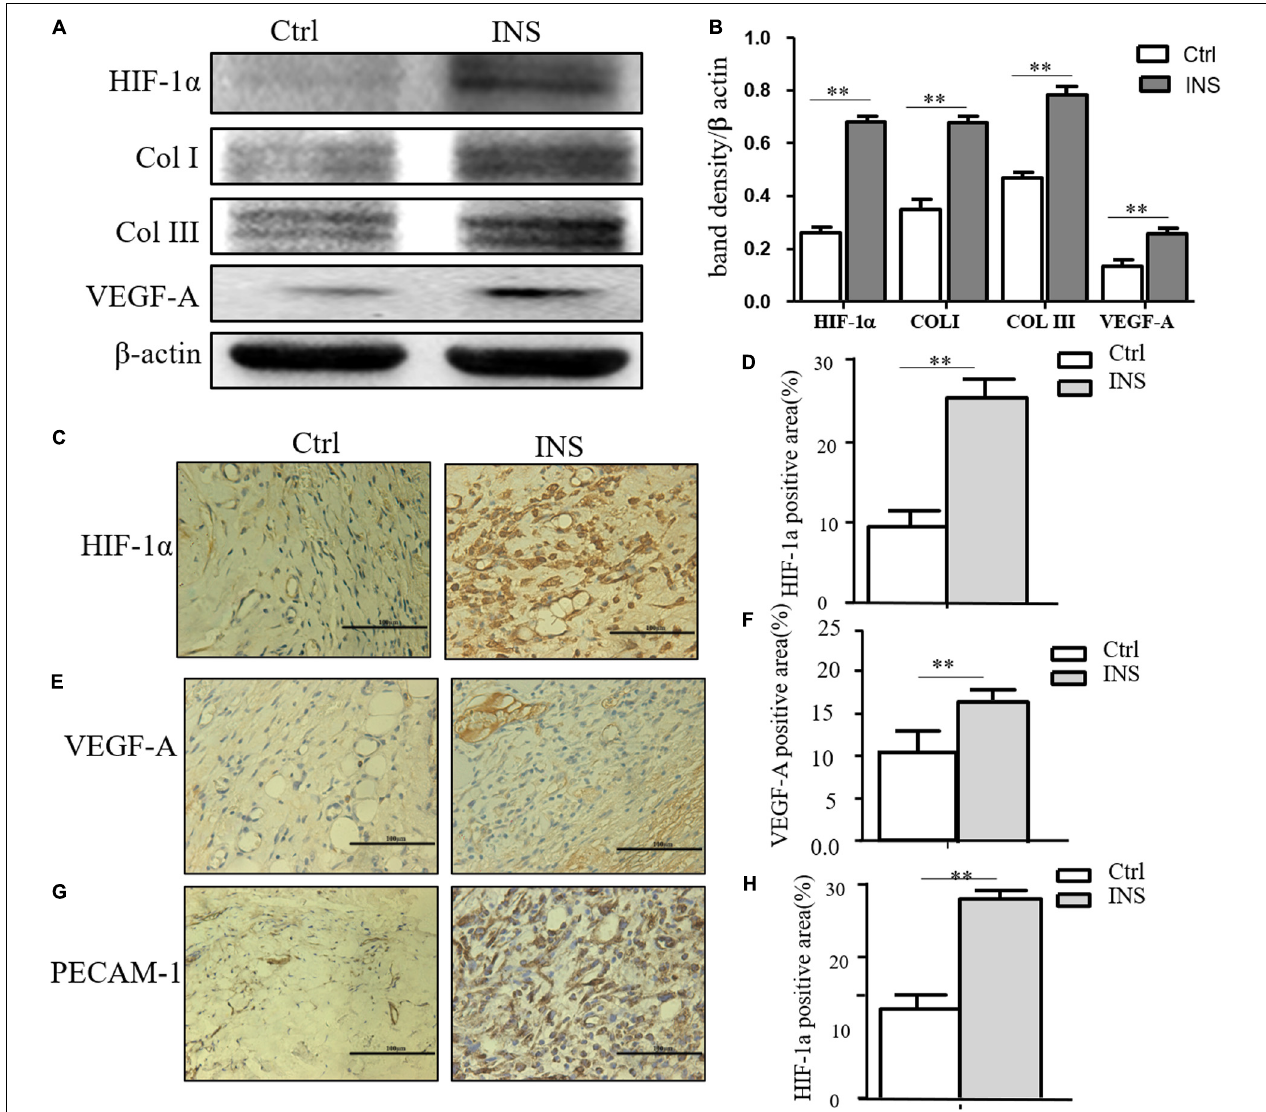
FIGURE 5 | Insulin-containing SF microparticles promoted diabetic wound healing through HIF-1 α stabilization. (A,B) Insulin-containing dressing promoted HIF-1 α stabilization and its downstream protein expression. The expressions of HIF-1 α and downstream protein Col I, Col III, and VEGF-A in wounds on the fifth day were analyzed using western blot, and Photoshop was used in the quantification of immunoblots. Data are shown as mean ± SD. ** p < 0.01, n = 5. (C–F) Immunohistochemistry examination of HIF-1 α and VEGF-A expressions and the positive area of the stain were calculated by ImageJ. Data are shown as mean ±